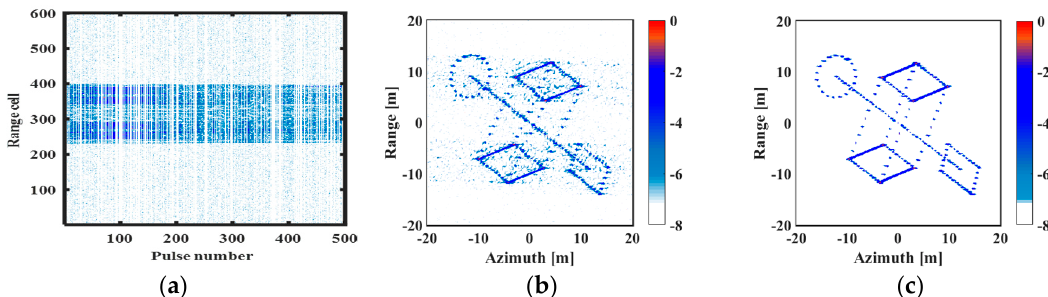
Figure 6. Range profiles and imaging results with RMS of 300 pulses: ( a ) Range profiles; ( b ) Imaging result of algorithm in [23]; ( c ) Imaging result of the proposed algorithm.